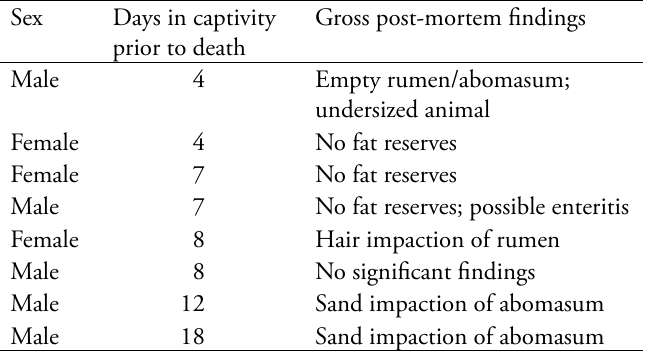
Table 3. Gross post-mortem findings for captive calves that died in captivity at South Georgia during January and February